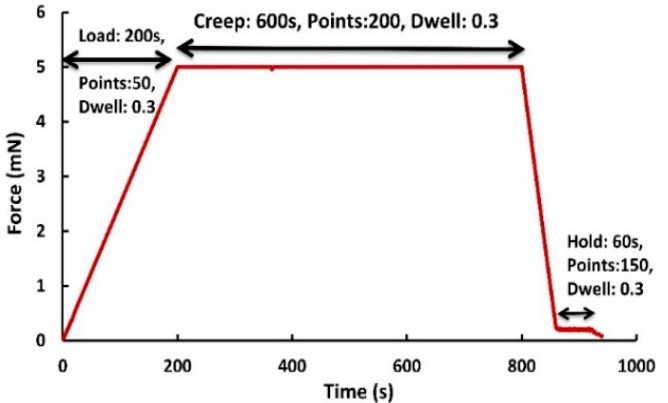
Figure 1. Four-step scheme of the load-hold-unload-hold nanoindentation test showing force-time characteristics.